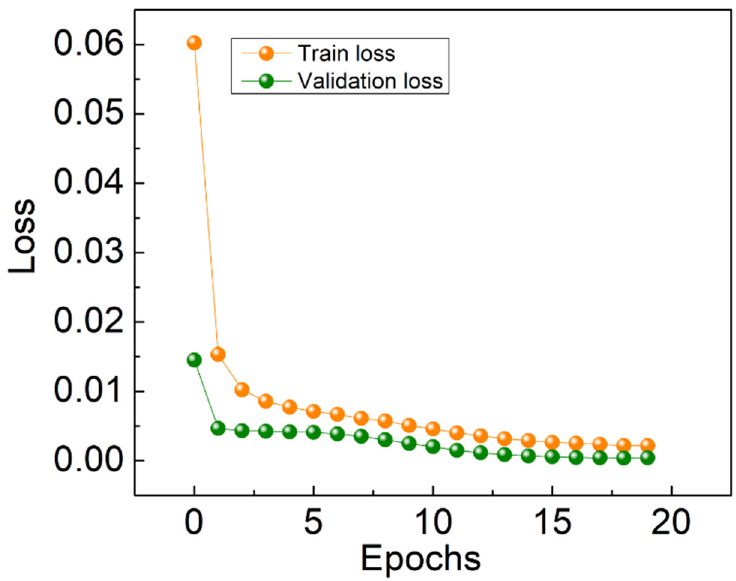
Figure 5. Loss value vs. number of epochs run using the Feed forward neural network.